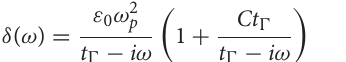
75 µ m, g 12 µ m, s 12 µ m, = = =